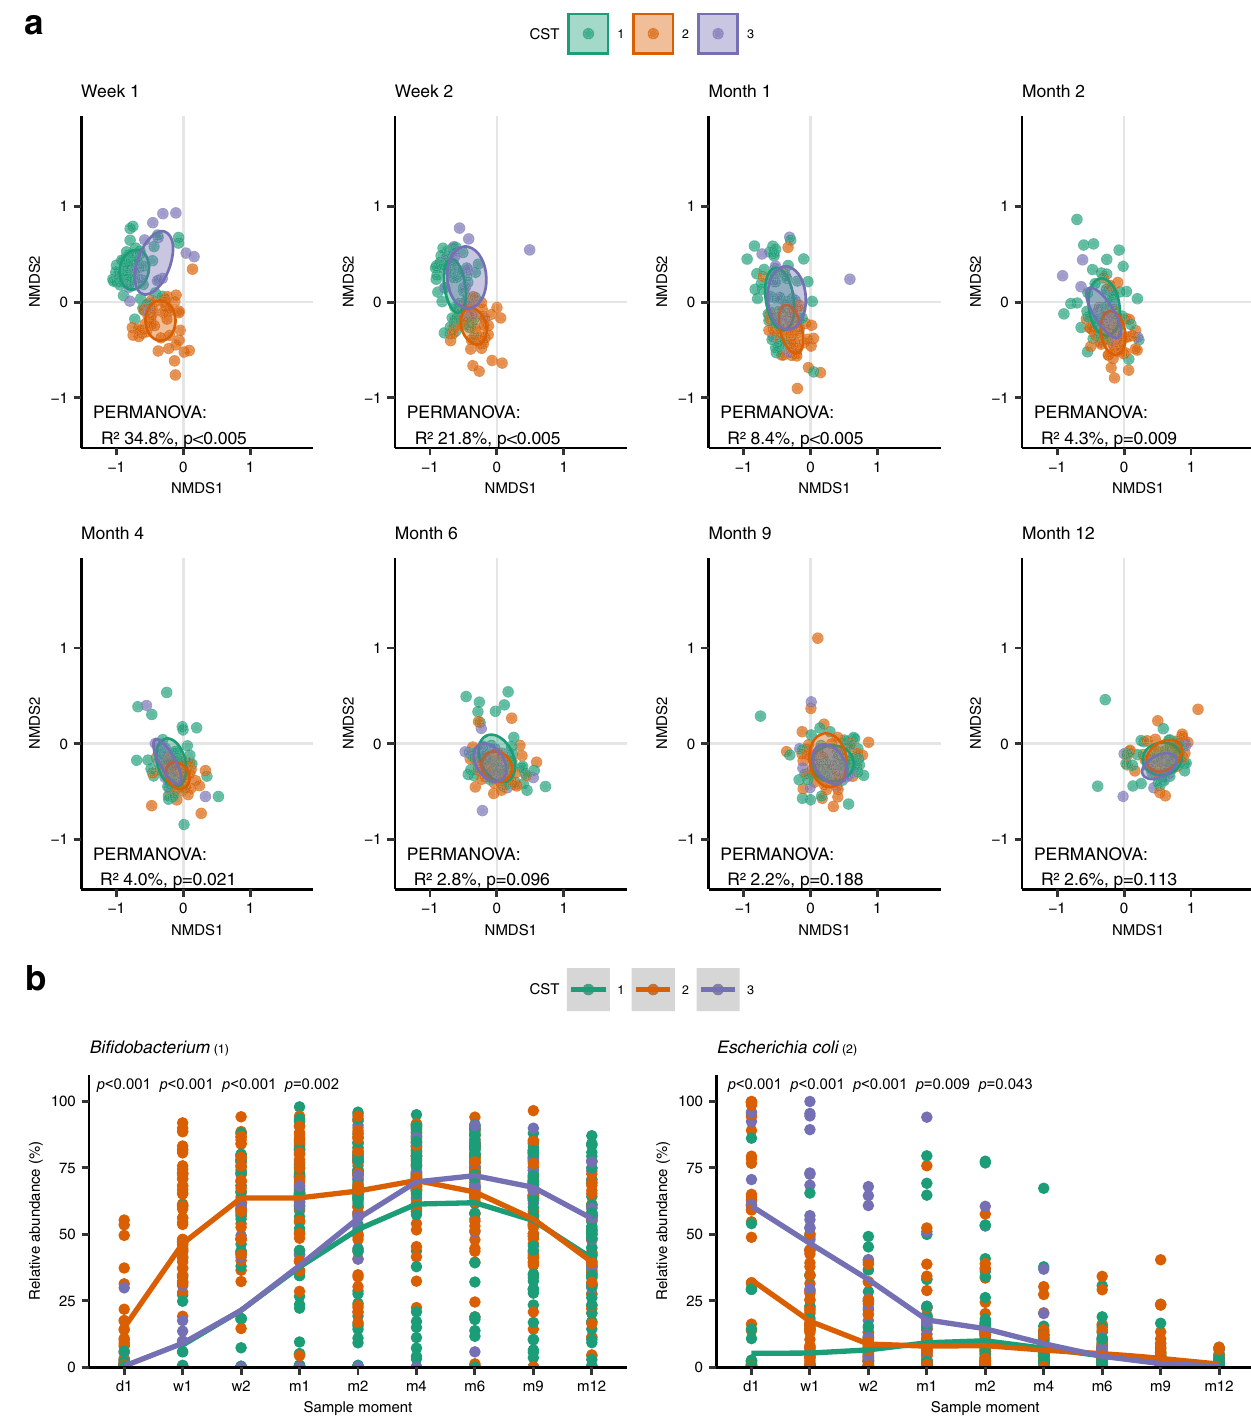
Fig.4 |Temporalgut microbialcompositiondevelopmentaccordingtoweek1 CST. a Non-metric multidimensional scaling (NMDS) plots based on Bray-Curtis dissimilarity, depicting the gut microbial composition per timepoint. Each dot represents the microbiota composition in a single participant ’ s sample. Infants are strati fi edaccordingtoweek1CST.Ellipsesrepresentthestandarddeviationofdata points for each CST. Effect sizes ( R 2 ) calculated by permutational analysis of